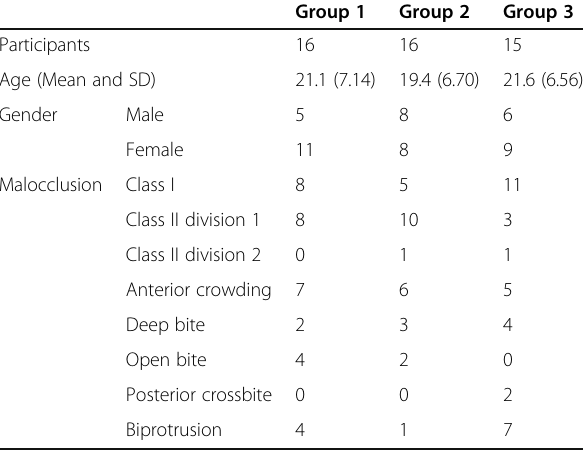
Table 1 Patient ’ s baseline